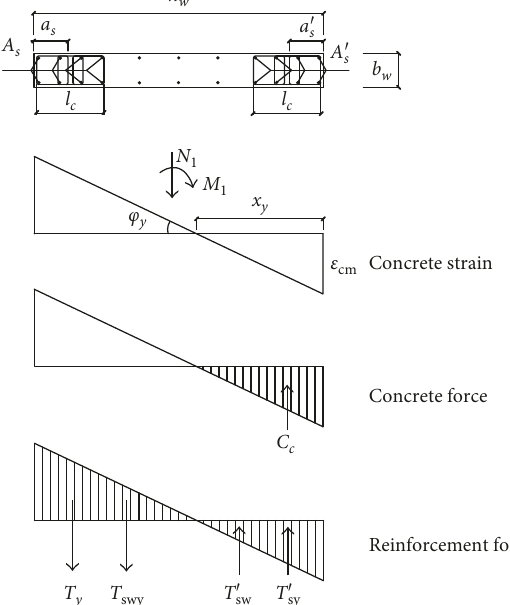
Figure 6: Stress and strain distribution profile in the yield